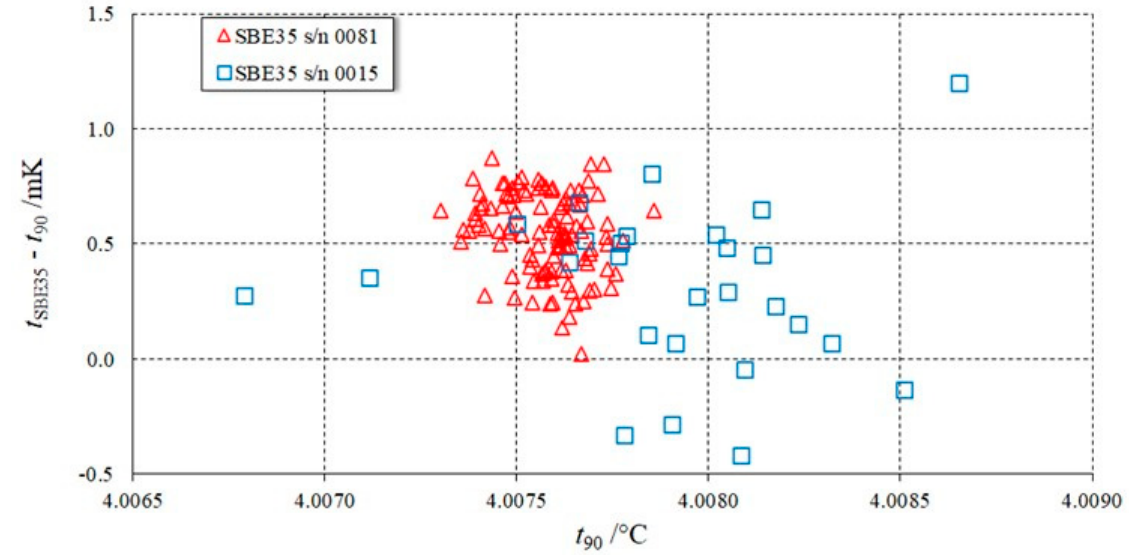
Figure 11. Temperature difference between the SBE35 reading, t SBE35 , and the water bath reference temperature, t 90 , as a function of t 90 for two SBE35 units (s/n 0015 and s/n 0081).